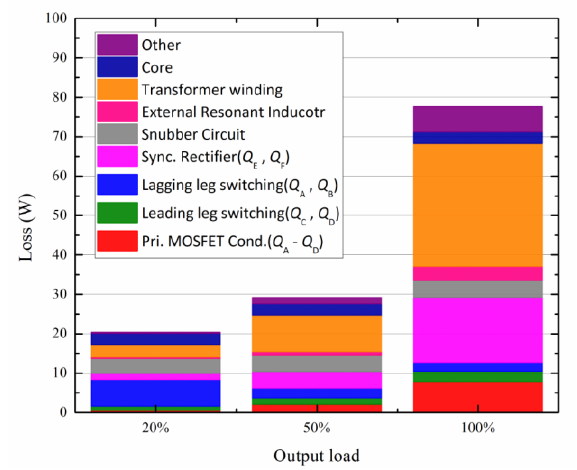
Figure 16. Loss Figure 16. Loss distribution.